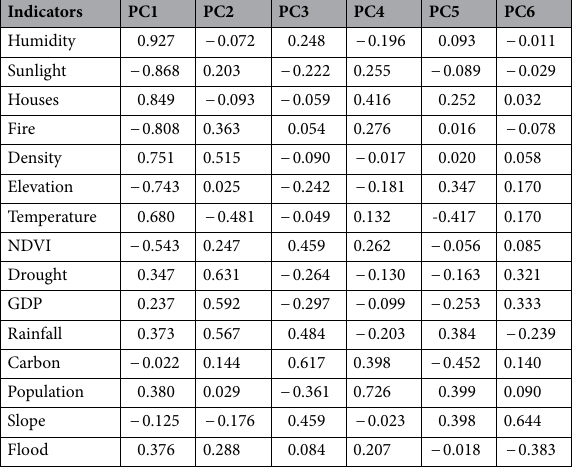
Table 3. Retained principal components constituents rate.